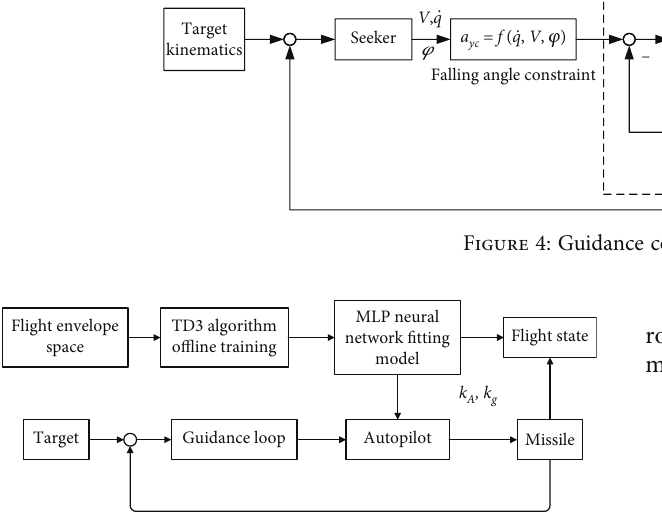
Figure 5: Design and online application framework of the autopilot based on the TD3 algorithm.